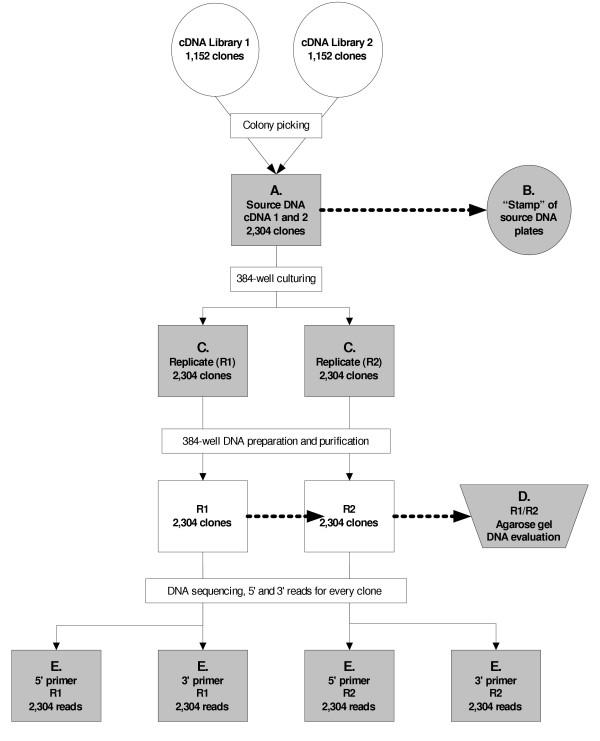
Process pipeline. Observational checks within the pipeline are shaded in grey. Absence of bacterial colonies, no-grows, and unusual observations are recorded on logsheets then entered into the FMA database. A. Verification of the colony picking procedure to ensure that all original clones are accounted for in the source microtiter plates. B. To further confirm A, we stamp a replicate of each microtiter plate containing transformed bacterial cultures onto agar plates. The resulting pattern of colonies is examined to determine presence or loss of DNA in each well of the source microtiter plate. C. Every 384-well culture plate is visually examined for presence of DNA after bacterial DNA culturing. D. Agarose gel electrophoresis is used to evaluate presence and quality of prepared and purified template DNA. E. During sequencing reactions, all volume additions are visually verified and manually adjusted using a single channel pipettor where necessary.